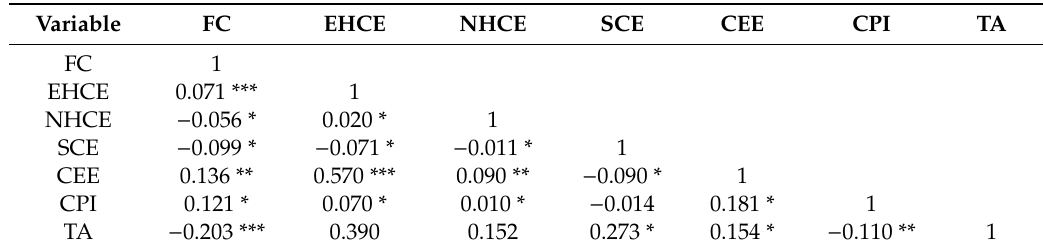
Table 2. Correlation coe ffi cients among variables in high-tech agriculture companies